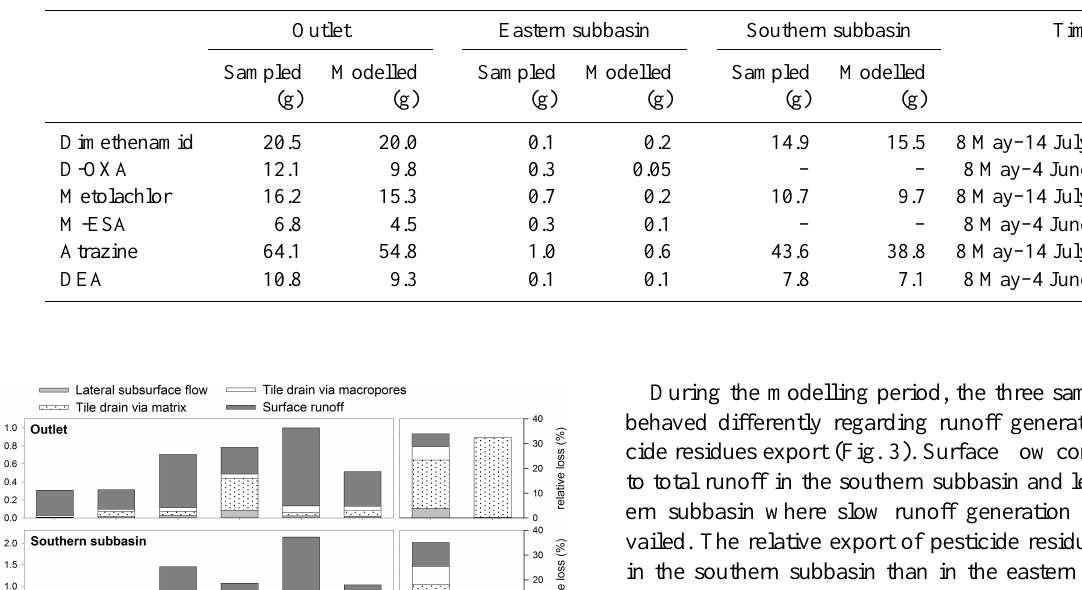
Table 4. Sampled and modelled substance loads at the three subbasin outlets.